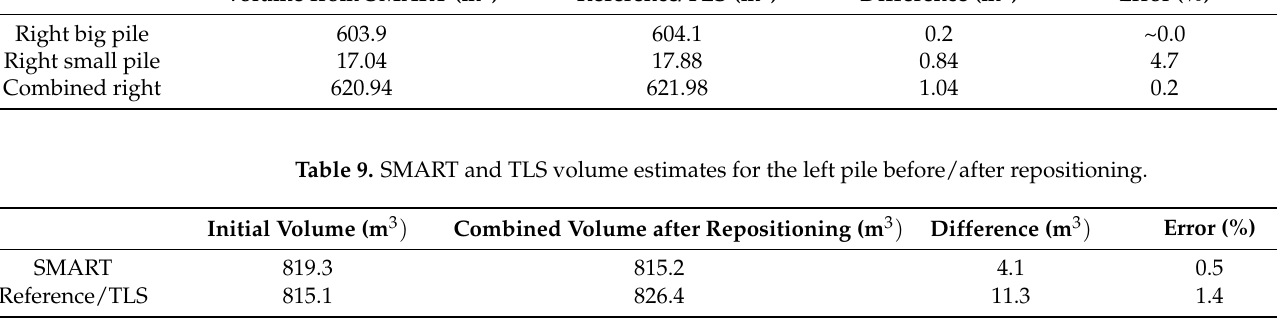
respectively ( left ), along with the corresponding small and big piles after repositioning ( right ).